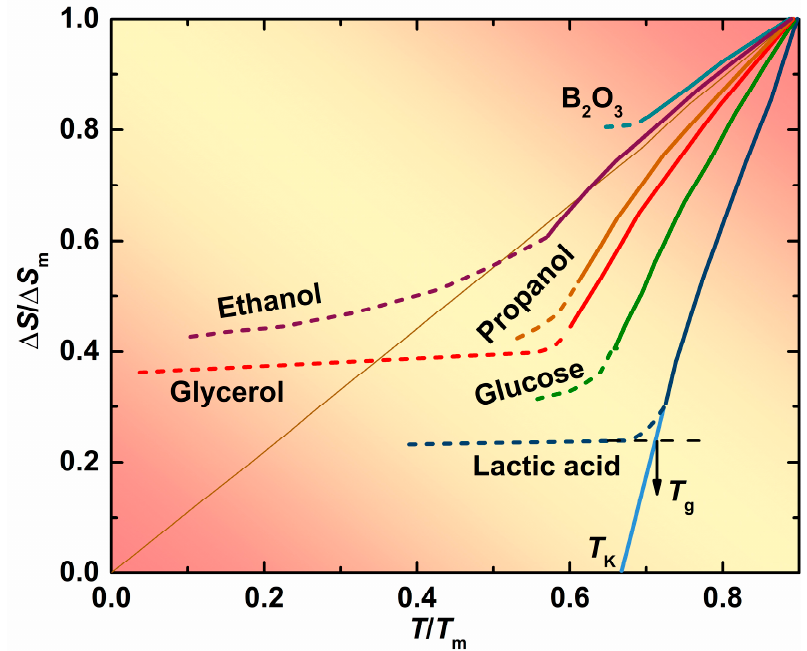
Figure 1. Temperature dependence of the difference in entropy between various supercooled liquids and their crystalline phases. ∆ S m and T m are the melt entropy and the melting temperature, respectively. (Adapted from Ref. [5,7]).